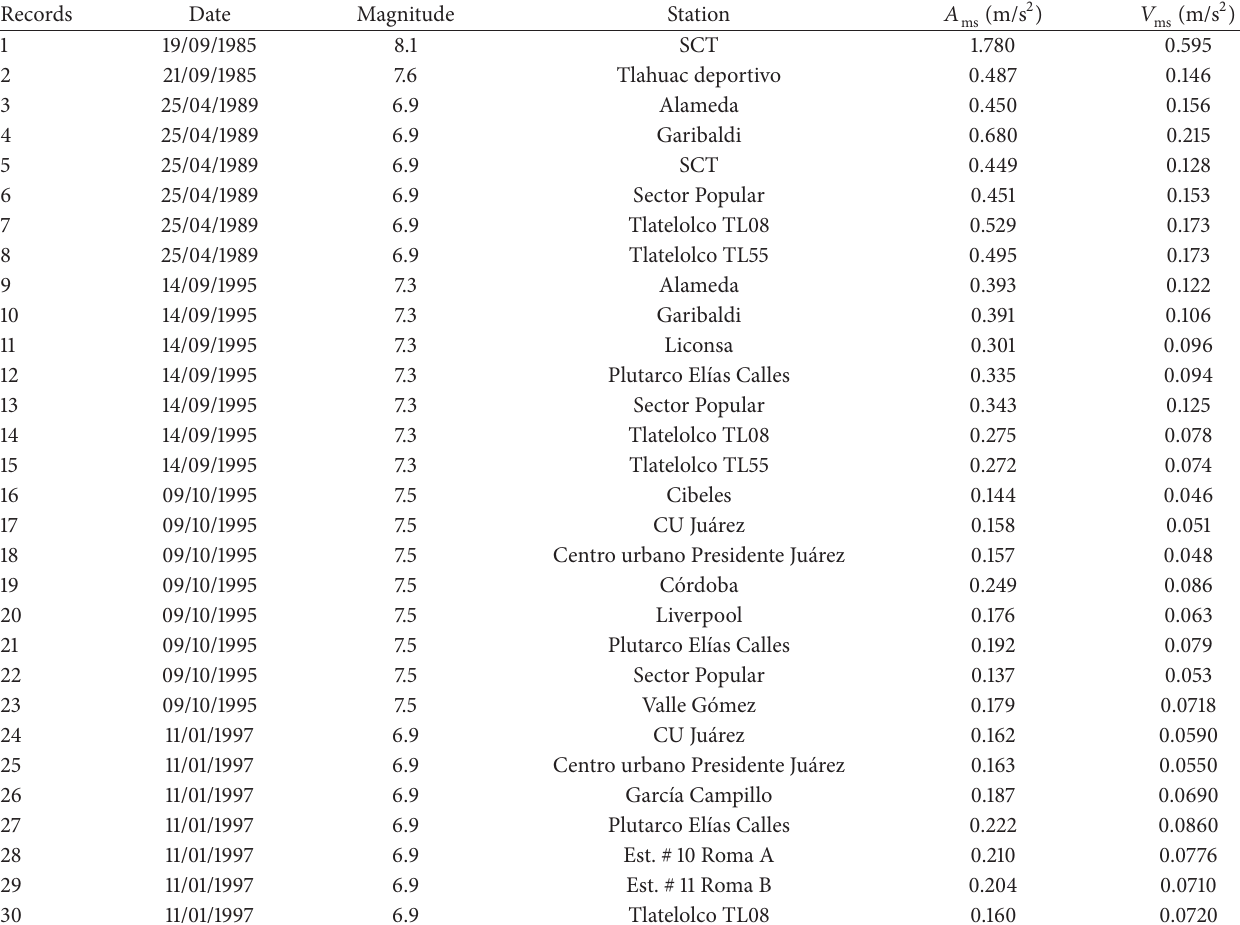
Table 3: Characteristics of the accelerograms